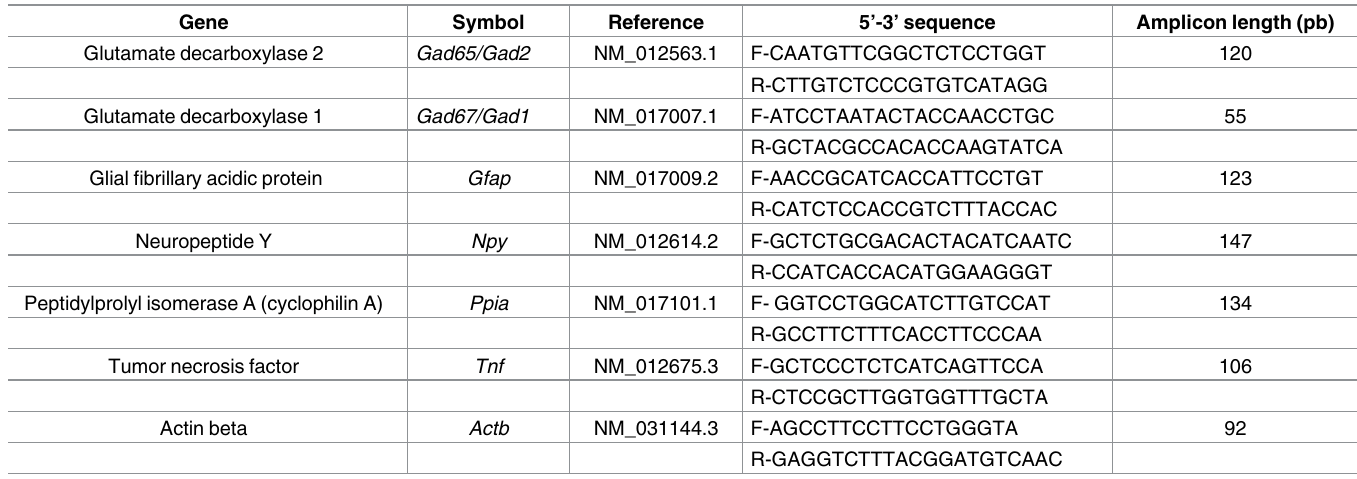
Table 1. Primer sequences and amplification